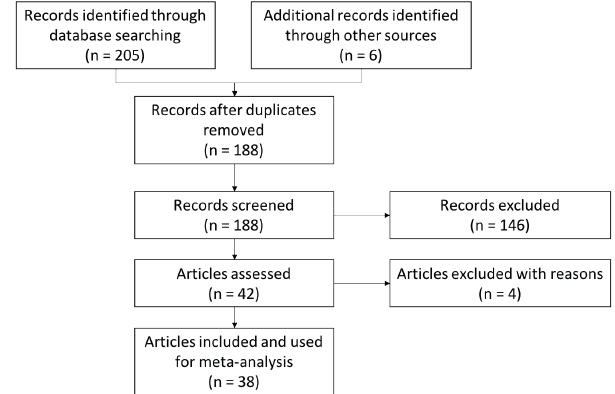
Figure 4. Results of the systematic literature